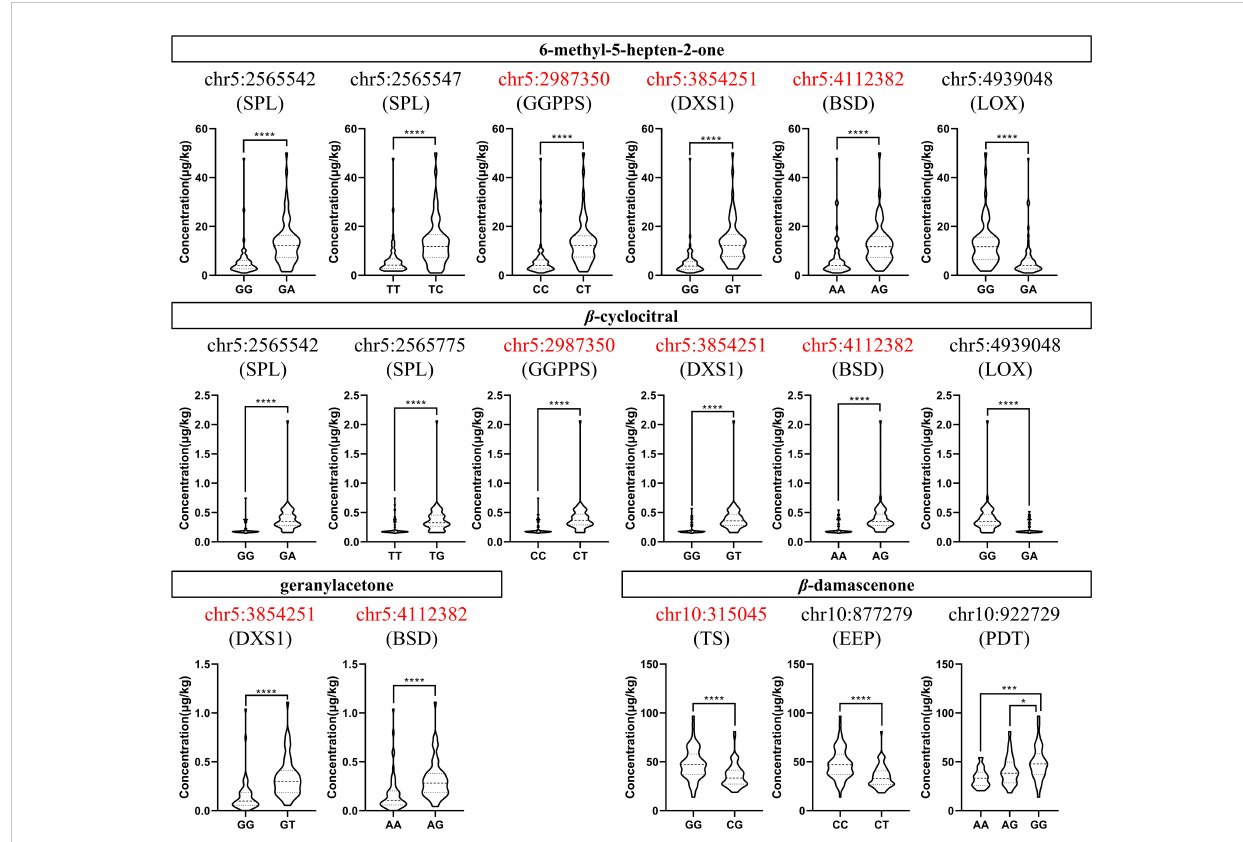
FIGURE 3 Concentration distribution violin plots of different genotypes at candidate SNP loci located in the coding sequence region of the genes in the F 1 population when the TSS was 16°Brix in 2017. The capital letters below the SNP loci are the symbols of the genes which these loci are located in. The SNP loci highlighted in red represent non-synonymous mutations. SPL, squamosa promoter-binding like protein 1; GGPPS, geranyl-geranyl diphosphate synthase; DXS1, 1-deoxy-D-xylulose-5-phosphate synthase1; BSD, BSD domain-containing protein; LOX, linoleate 9S-lipoxygenase 5; TS, tryptophan synthase; EEP, endonuclease/exonuclease/phosphatase family; PDT, prephenate dehydratase. The asterisks *** and **** indicate signi fi cant levels at p <0.001 and p <0.0001, respectively. Concentration distribution violin plots of different genotypes at candidate SNP loci located in the coding sequence region of the genes in the F 1 population when the TSS was 10°Brix and in 16°Brix in 2018 were shown in Supplementary Figures S3, S4, respectively. The asterisks * indicates signi fi cant levels at p